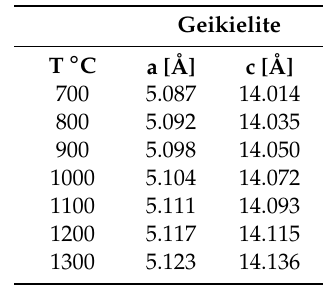
Table 6. Lattice parameters of MgTiO 3 as function of temperature in a previous investigation [4] of sol-gel product.